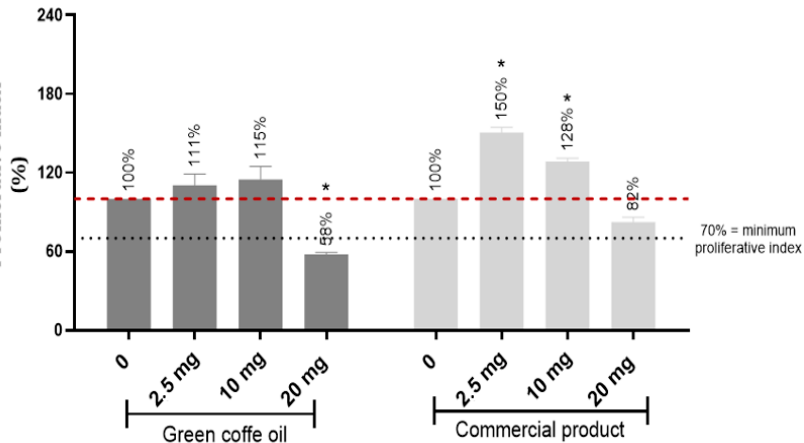
Figure 5. Cell survival fractions observed in human keratinocytes after 24 h of treatment with dif- ferent concentrations of green co ff ee oil. * Signi fi cantly di ff erent from the negative control ( p < 0.05). The assay was performed in